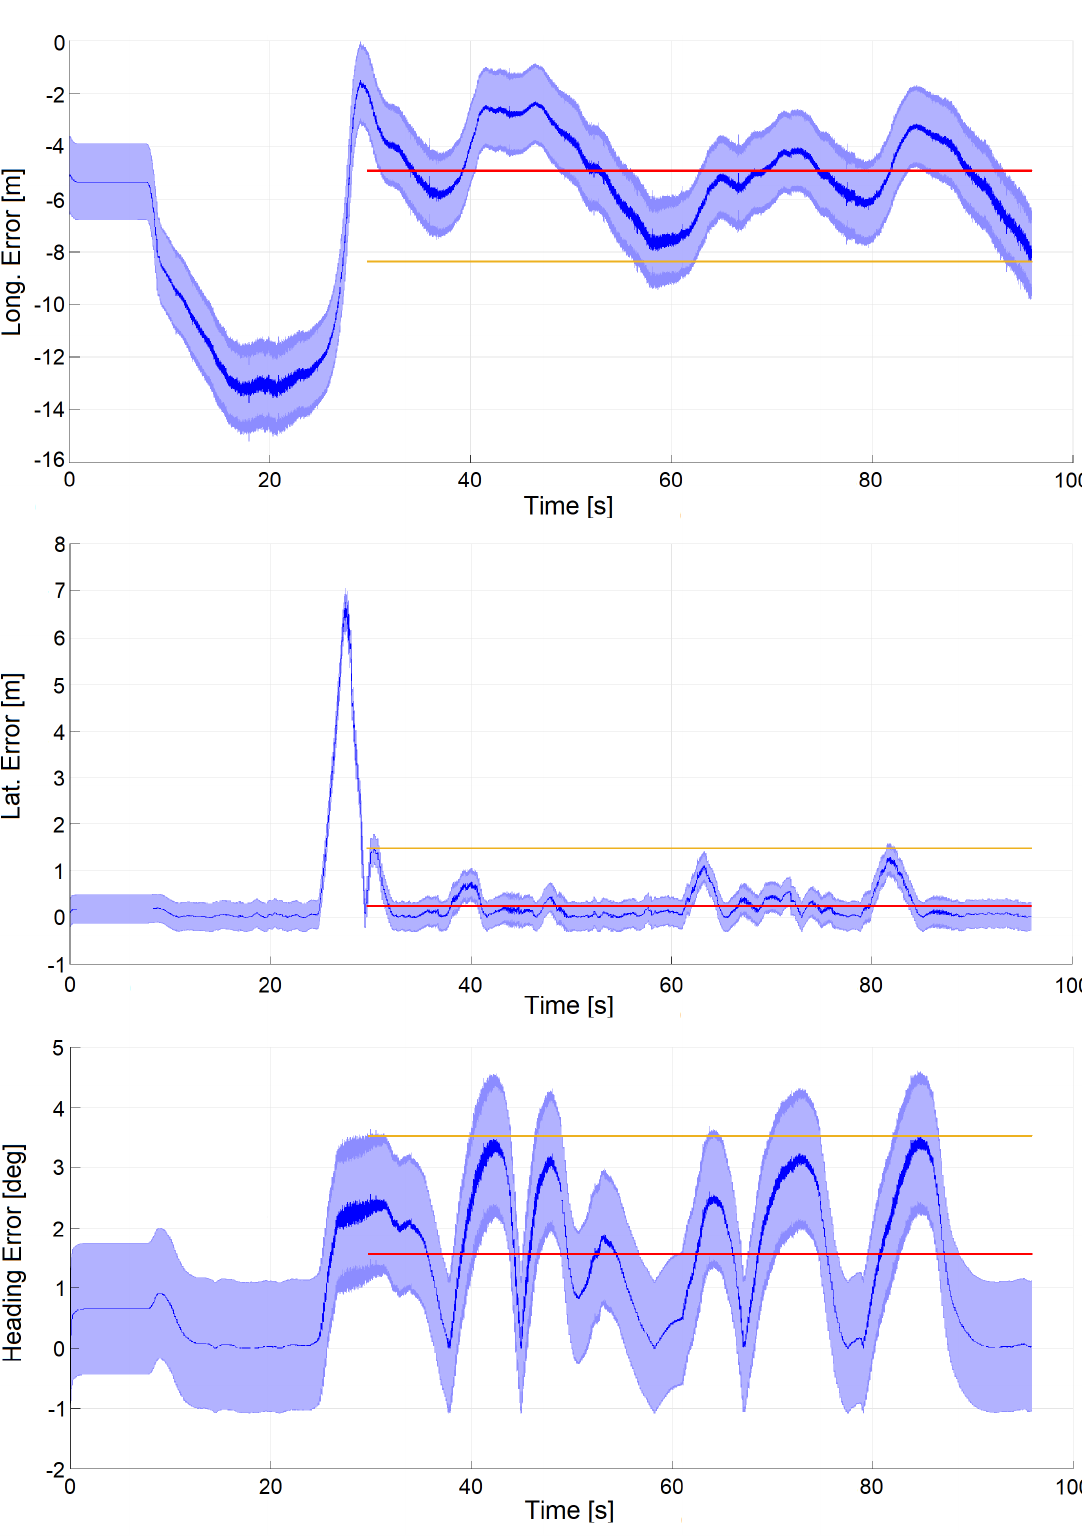
Figure 16. Autonomous lap in simulation at v max = 200 km/h. Signals are plotted together with standard deviation (light blue), mean (red) and maximum error (yellow). The measurement of such metrics starts when the car actually starts driving after